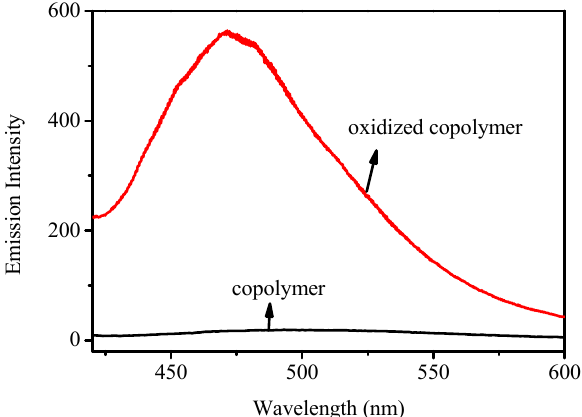
Figure 10. PL spectra of copolymer and oxidized copolymer at solid state, excited at 370 nm.